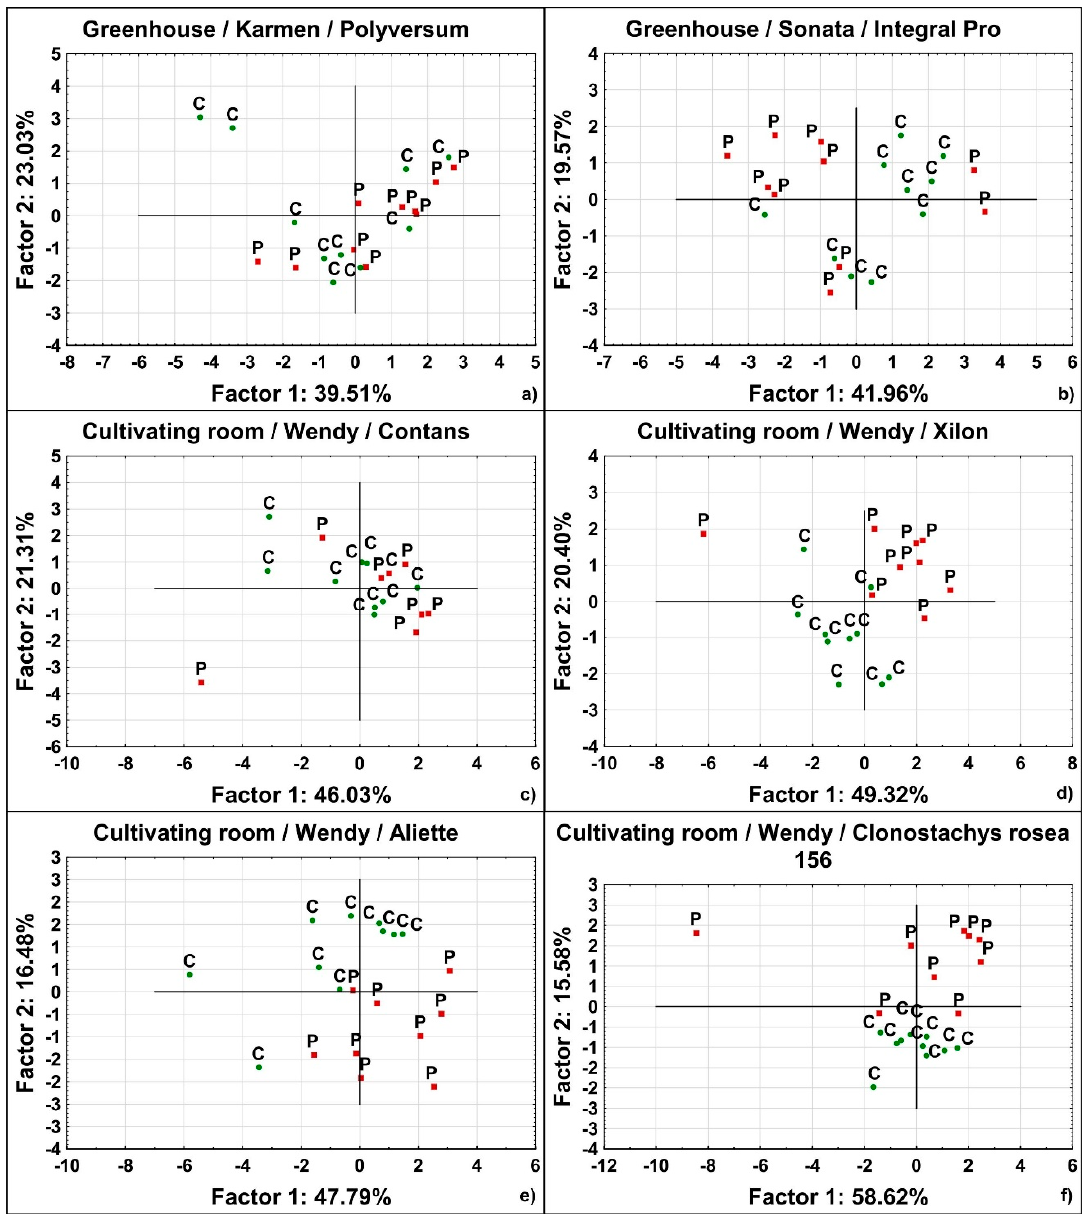
Figure 1. The examples of results of the principal component analysis comparing the plants infected by Phytophthora cactorum (P) with uninfected control plants (C), where all the plants were treated by tested BCAs. The overlap of the clouds of P and C points in the charts ( a ) is interpretable as low or no differentiation between plants caused either by the protective effect of BCAs on infected plants or by the negative influence of BCA alone, while their clear differentiation ( f ) could mean the result of different growth and different health of infected plants in consequence of pathogen infection. The subfigures ( a – f ) show the continuing tendency between those utmost cases.